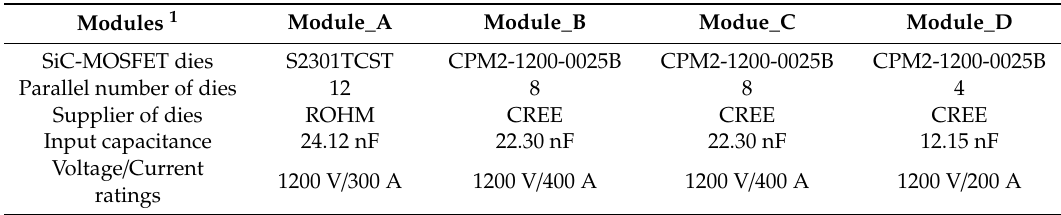
Table 1. The used SiC dies inside the developed power module.